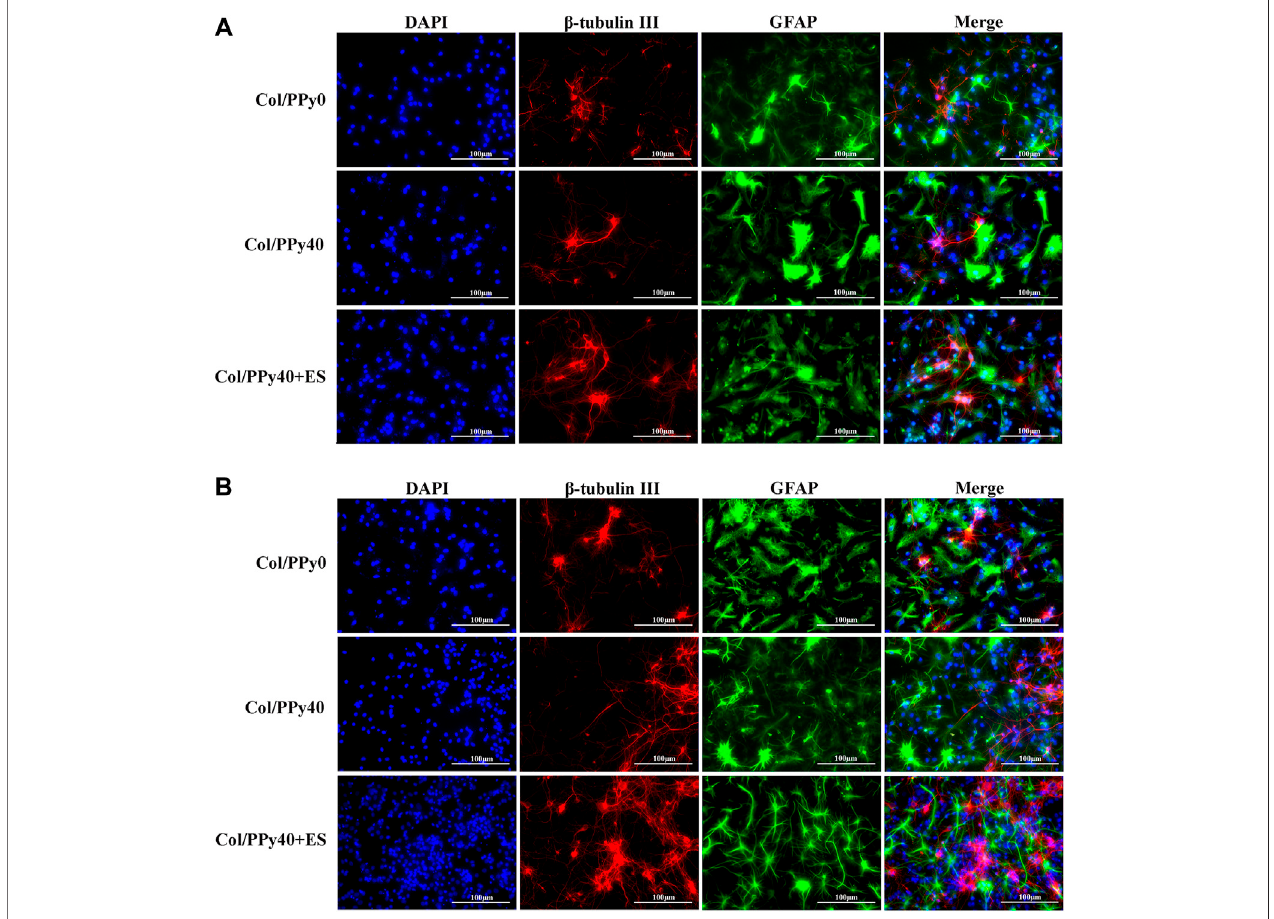
FIGURE 7 | Confocal microscopy images of NSCs differentiation with the prepared hydrogels into β -tubulin III positive cells (for neurons, shown in red) and GFAP positive cells (for astrocytes, shown in green) on day 3 (A) and day 7 (B) . All cell nuclei were DAPI stained (shown in blue).